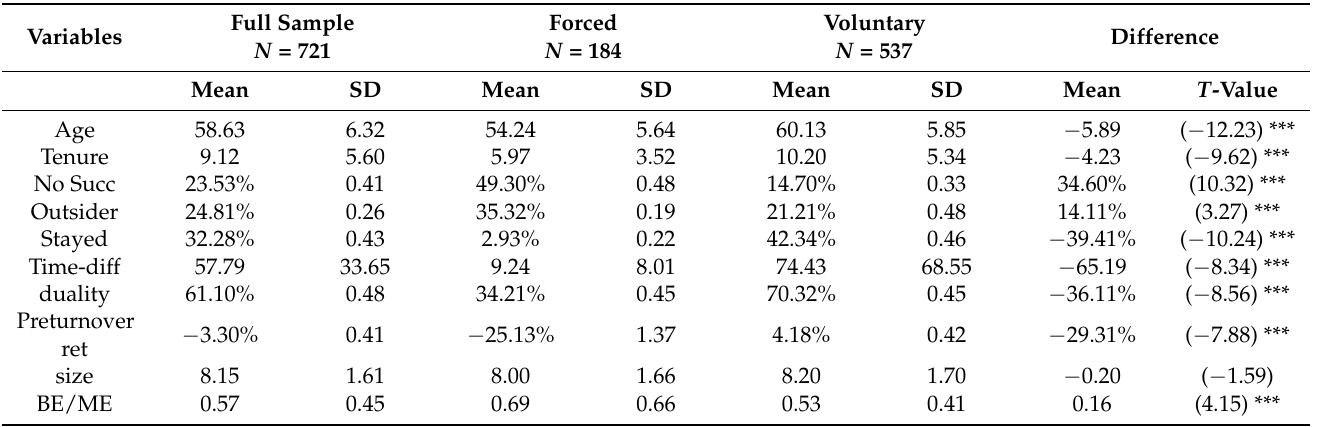
Table 1. Descriptive statistics.